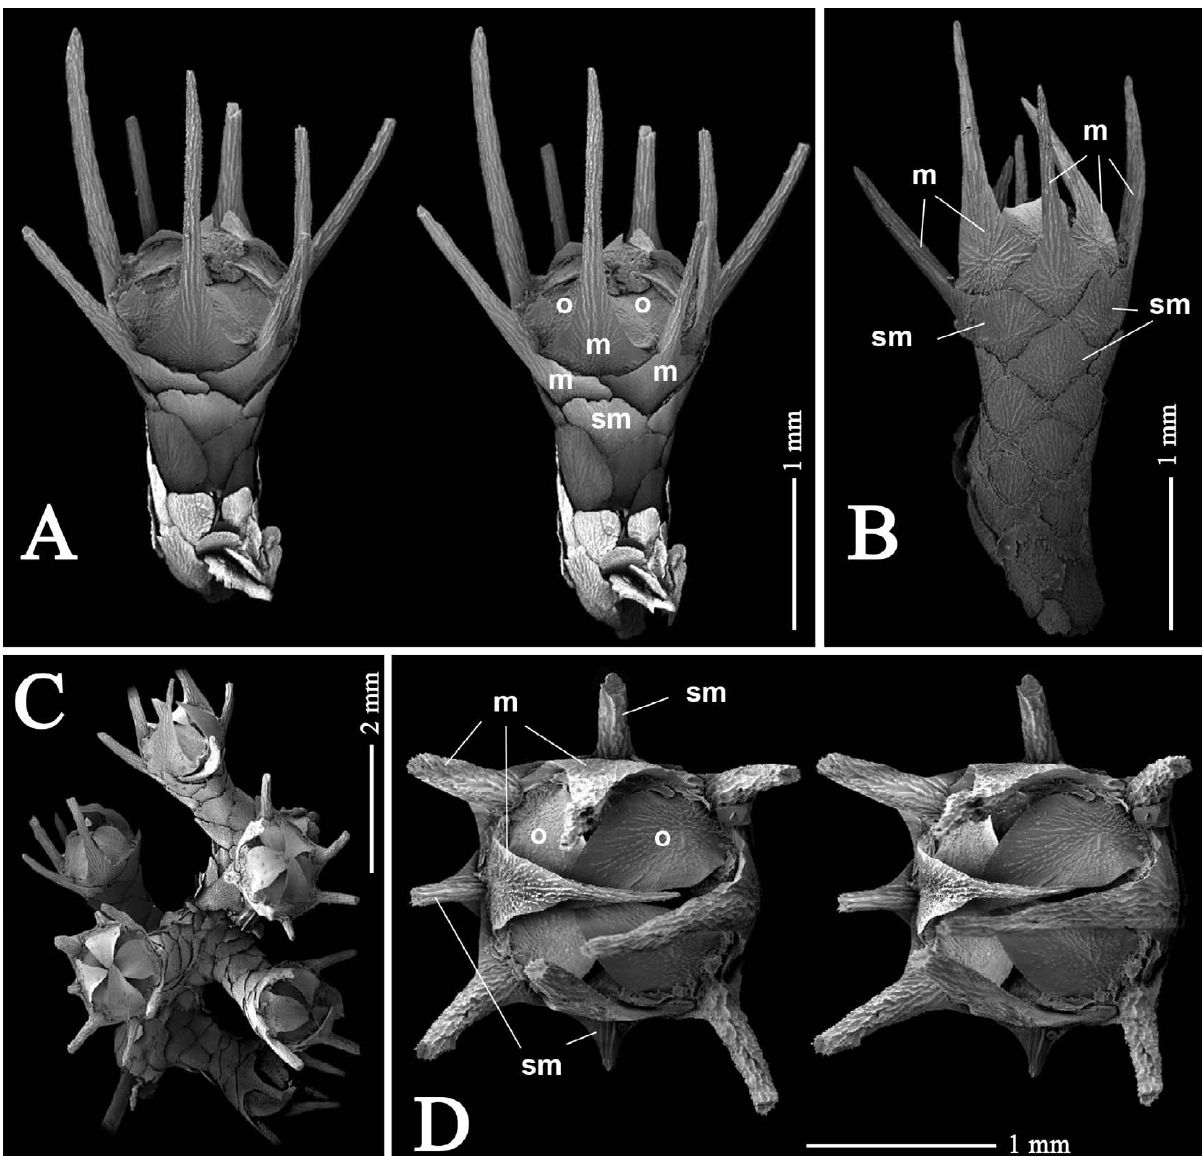
Fig . 5. – Thouarella sardana n. sp., holotype ZiZMH c11740: a, polyps in adaxial view, stereo pair; b polyps in abaxial view; c, detail of branchlet; d, polyps in oral view, stereo pair. abbreviations: o, opercular scales; m, marginal scales; sm, submarginal